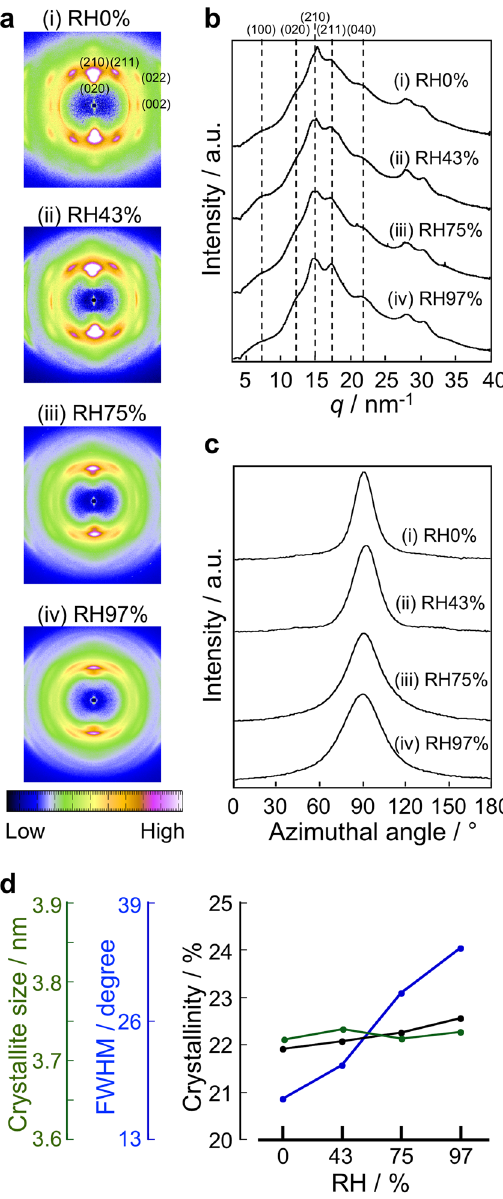
Fig. 5 Retardation and birefringence of spider dragline silk fi bers. a Optical micrographs and retardation color mapping of spider dragline silk fi bers incubated at (i) RH0%, (ii) RH43%, (iii) RH75%, and (iv) RH97%. Each scale bar denotes 30 µ m. The retardation values ranged from 0 to 200 nm, as shown in the color scale. b Birefringence value as a function of RH. *Signi fi cant differences between groups at p <